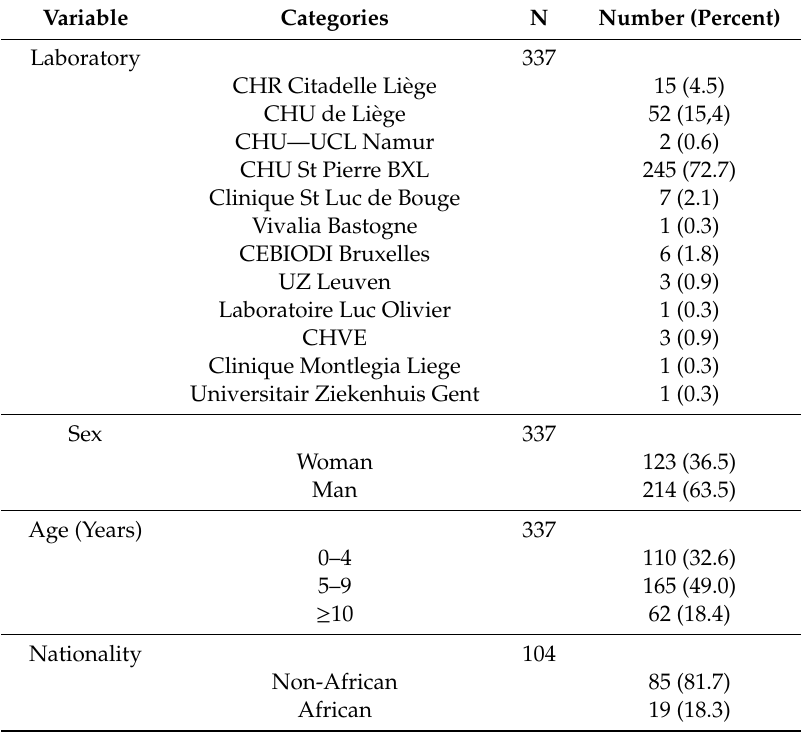
Table 1. Distribution of the 337 cases of tinea capitis by laboratory, sex, age, and nationality.